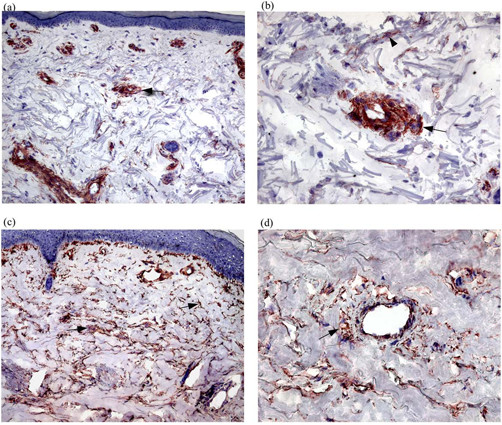
Expression of Thy-1 is increased in dcSSc skin. Cryosections from (a,b) normal and (c,d) dcSSc were stained for Thy-1 expression. In normal skin, immunostaining for Thy-1 was predominantly located within the microvascular wall and immediate perivascular region ((a,b) arrows). Thy-1 staining of interstitial fibroblasts was also detected ((b) arrowhead). In dcSSc skin, immunostaining of fibroblastic cells was considerably more pronounced throughout the interstitial dermis ((c) arrows) while perivascular immunostaining in dcSSc skin ((d) arrow) was less pronounced than that observed in normal skin ((b) arrow). dcSSc, diffuse cutaneous systemic sclerosis.